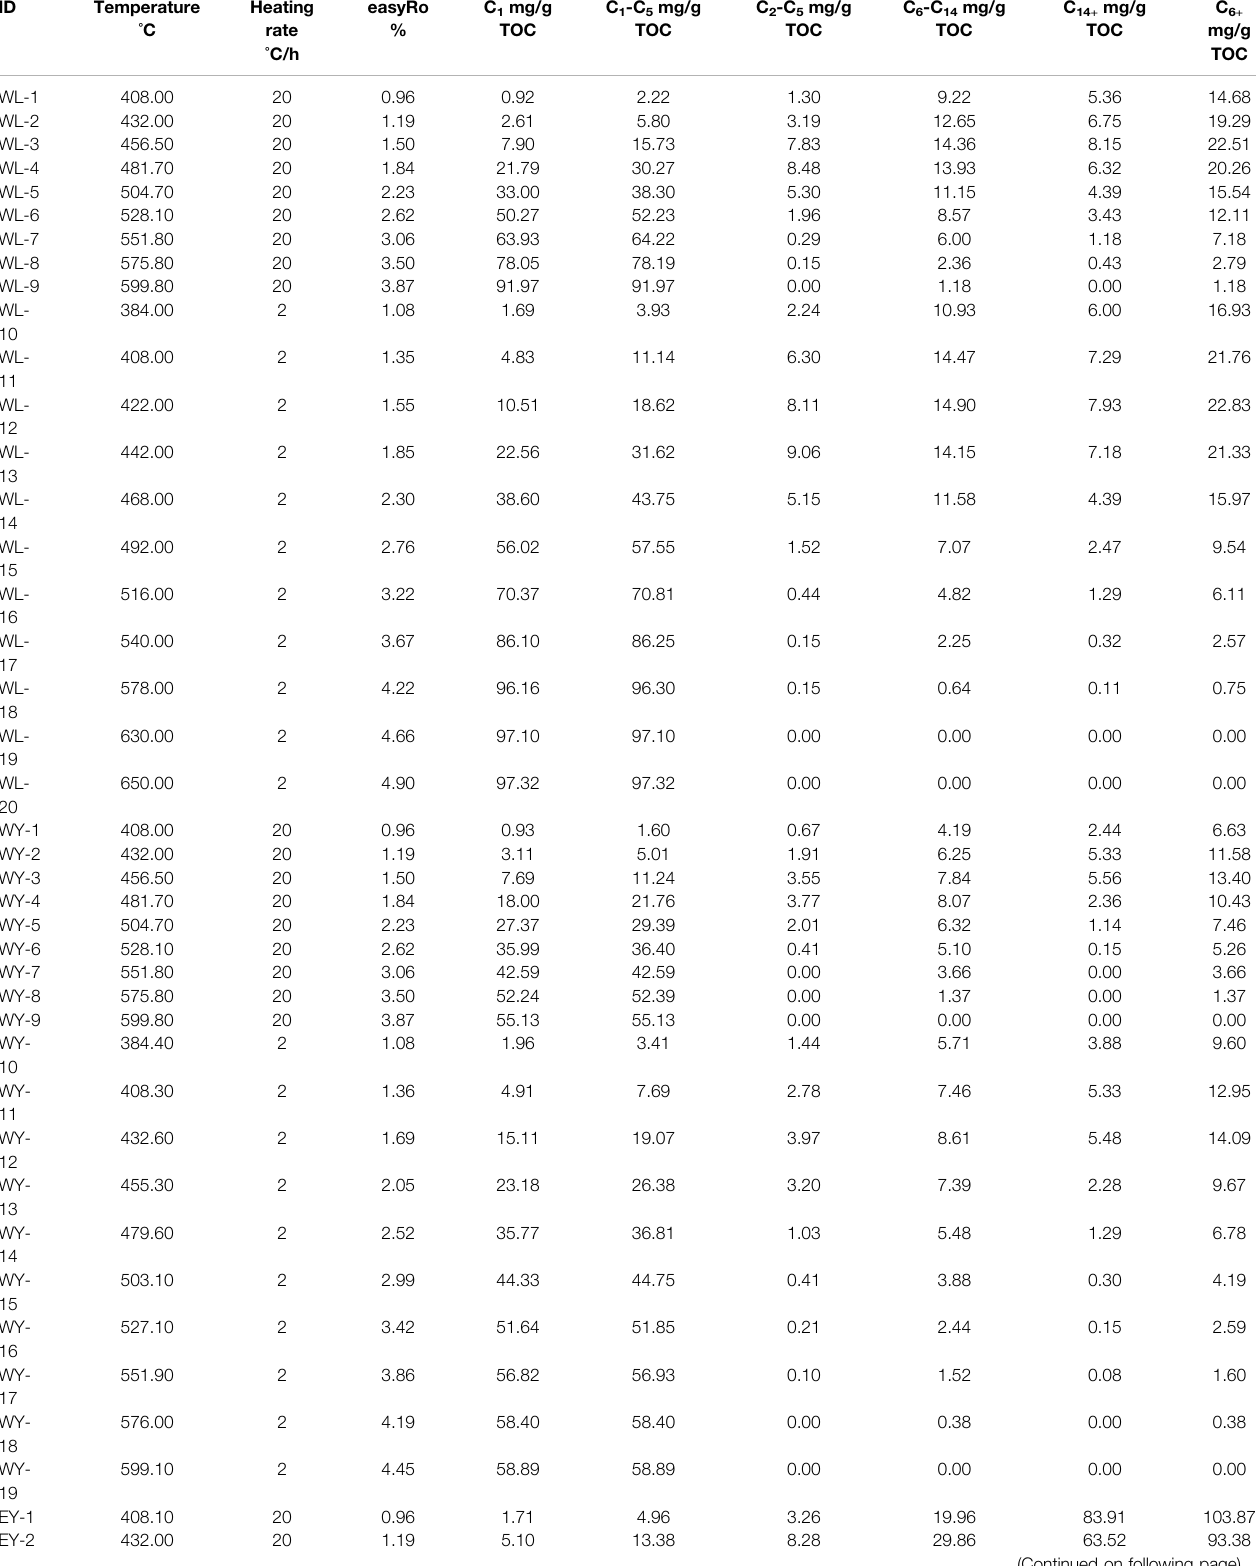
TABLE 2 | Yield and carbon isotope data of different compositions by gold tube hydrocarbon generation simulation experiment. ID Temperature °